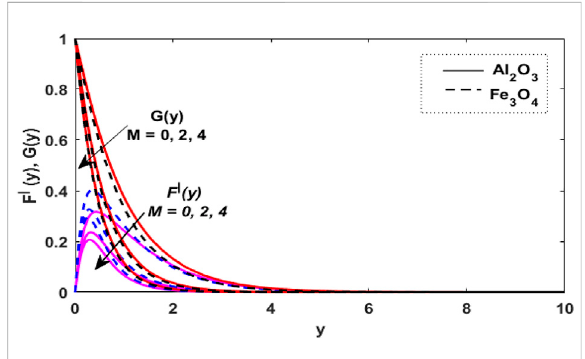
FIGURE 2 In fl uence of M on F I (y) and G(y) when ϕ = 0.01, ∈ = 1, and Pr = 29.86.